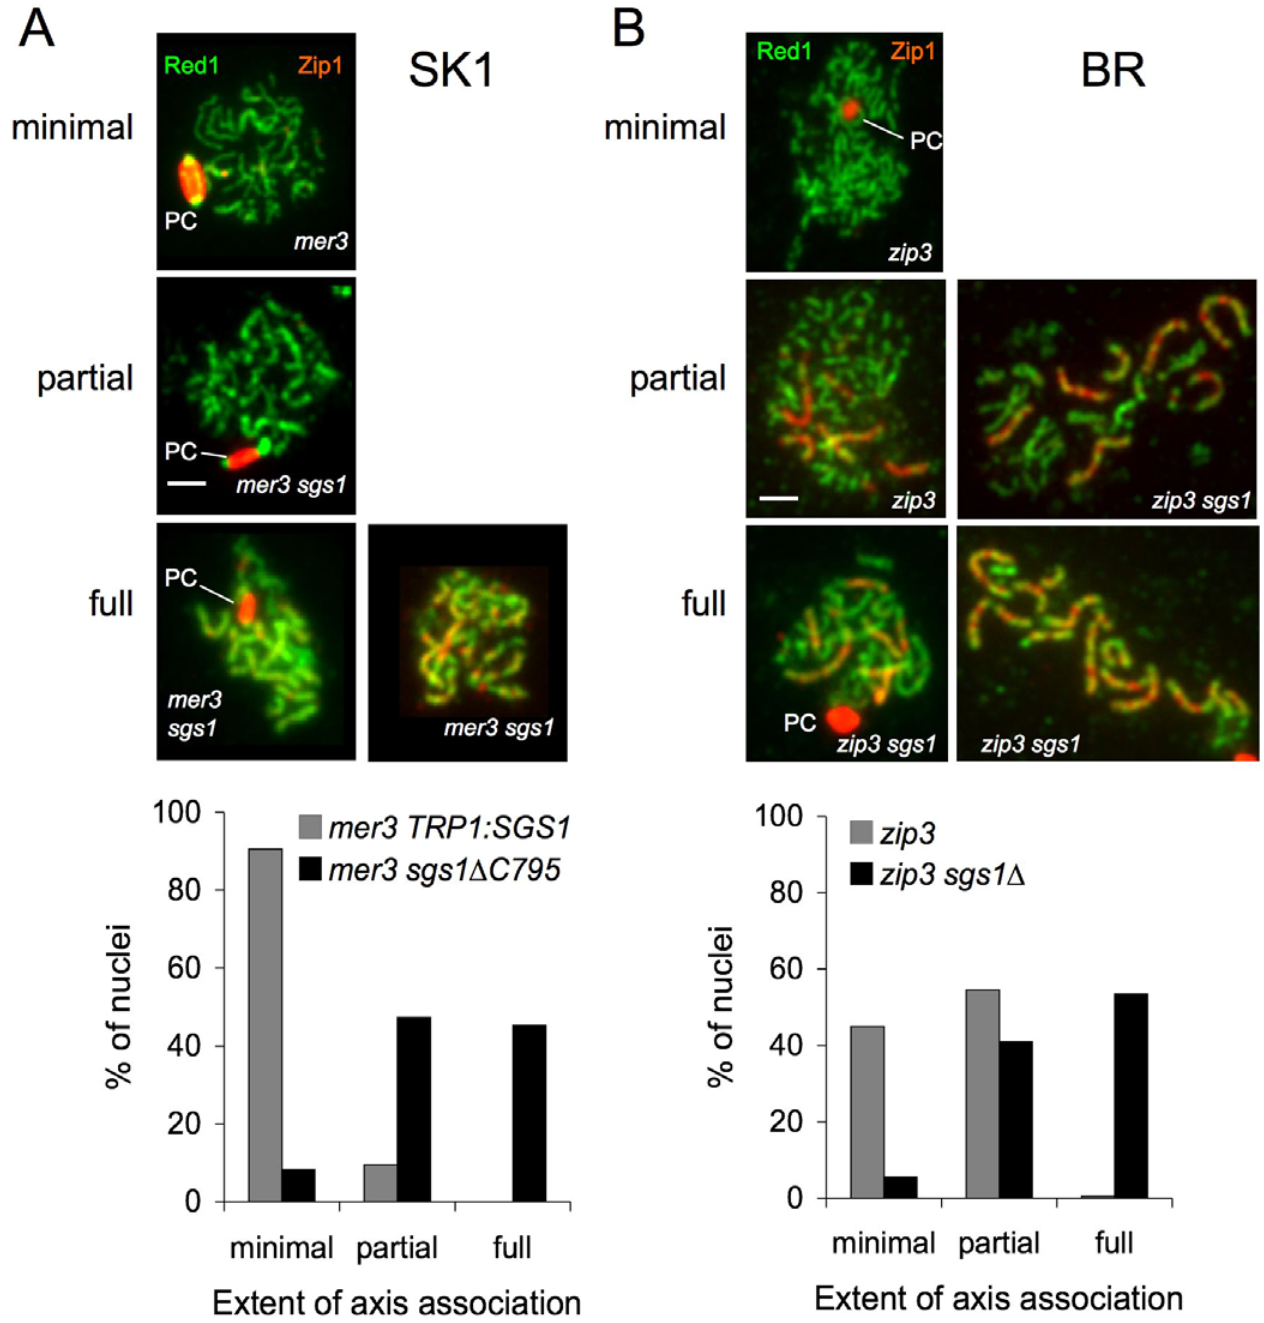
Figure 4. Sgs1 Prevents AA in mer3 D and zip3 D Mutants (A) Analysis of AAs in TRP1:SGS1 mer3 D and mer3 D sgs1 D C795 SK1 strains. Nuclei from cells harvested 5 h after initiation of sporulation were surface spread and probed with anti-Zip (red) and anti-Red1 (green) antisera. Nuclei where chromosomes displayed linear Red1 were examined and classified as displaying minimal, partial, or full pseudosynapsis, as described in Materials and Methods. Nuclei with fully associated chromosomes displayed discontinuous Zip1 staining (right-hand example), Zip1 localization in polycomplexes (PC, left-hand example), or both. White bar: 2 microns. (B) Analysis of AAs in zip3 D and zip3 D sgs1 D BR strains. Nuclei from cells harvested 18 h after the initiation of sporulation were spread, stained, and analyzed as for mer3 strains. In most nuclei with full AA, at least some chromosome pairs displayed end-to-end Zip1 staining with the remainder being pseudosynapsed. DOI: